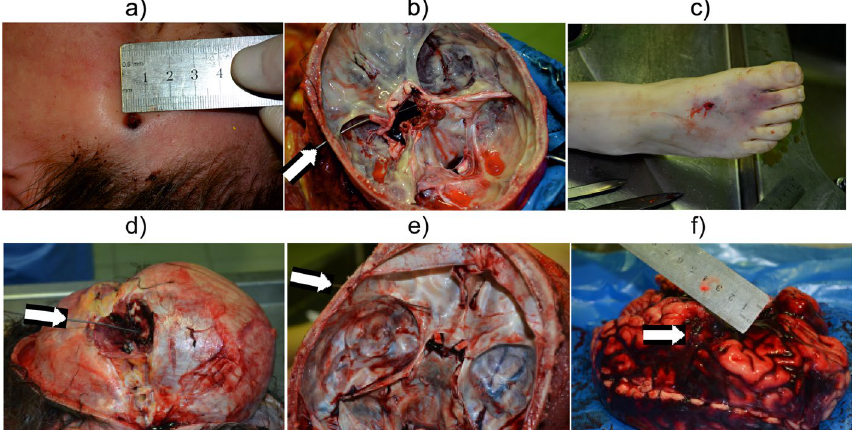
Fig. 3 Entrance wound and trajectory a left cranial entrance wound, b trajectory of airgun pellet in the skull, c right foot entrance wound, d left temporal muscle hematoma with the entrance wound, e basal of the cranium (the arrow indicates wound entering cranial cavity), f massive diffuse subarachnoid hematoma (the arrow indicates arachnoid laceration on the borderline od left temporal and frontal